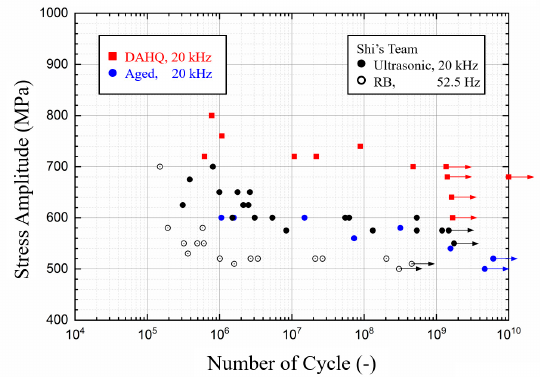
Figure 8. VHCF property comparison with Shi’s team [22,23].